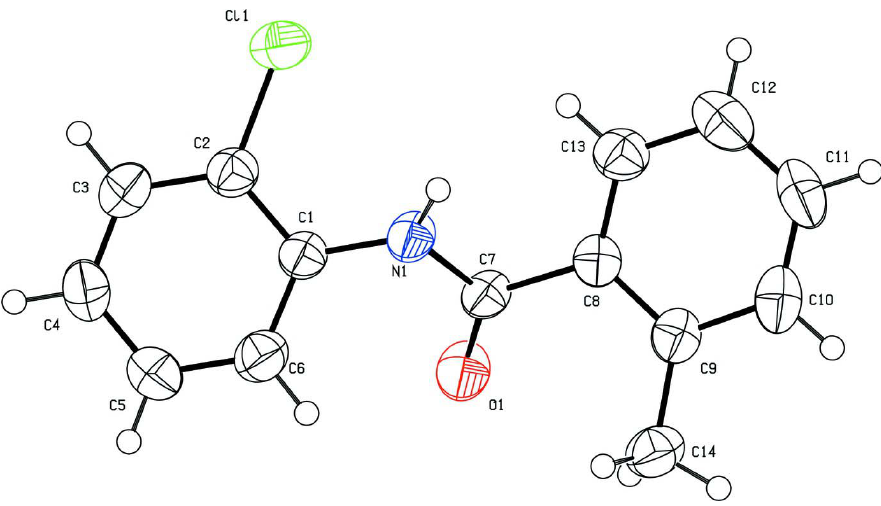
Figure 1 Molecular structure of the title compound, showing the atom labeling. Displacement ellipsoids drawn at the 50% probability level.